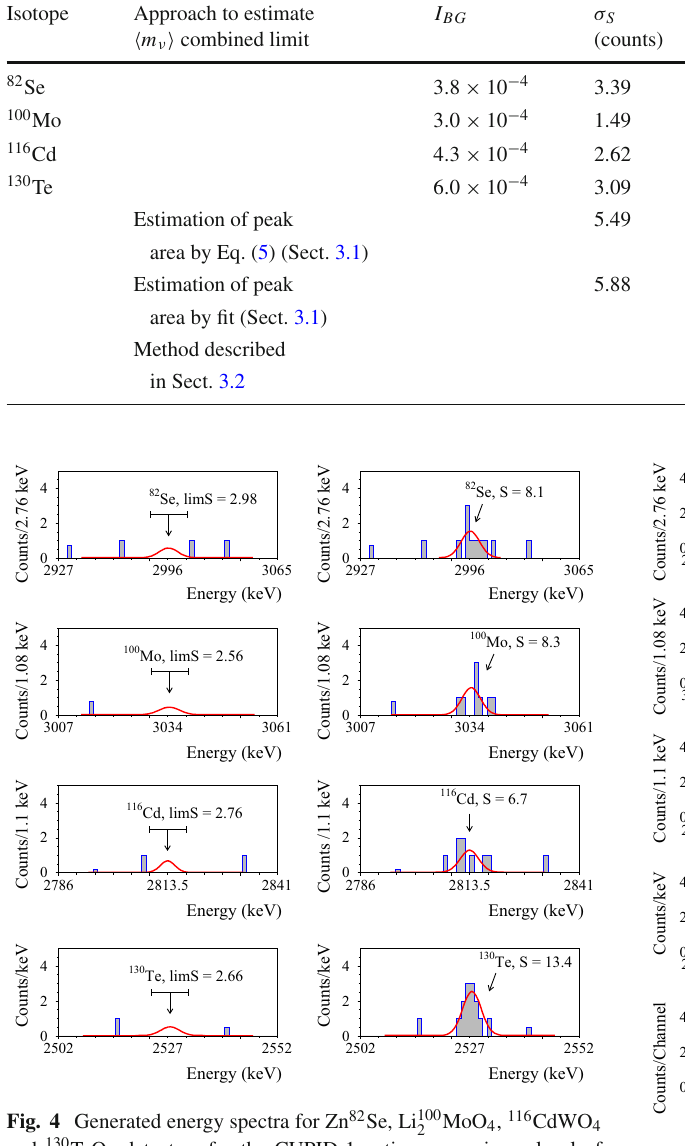
Table 3 Sensitivity of the CUPID-4 experiment with Zn 82 Se, Li 100 MoO 4 , 116 CdWO 4 and 130 TeO 2 detectors assuming the level of 2 background simulated in Ref. [44] (denoted as I BG , counts/yr/keV/kg).